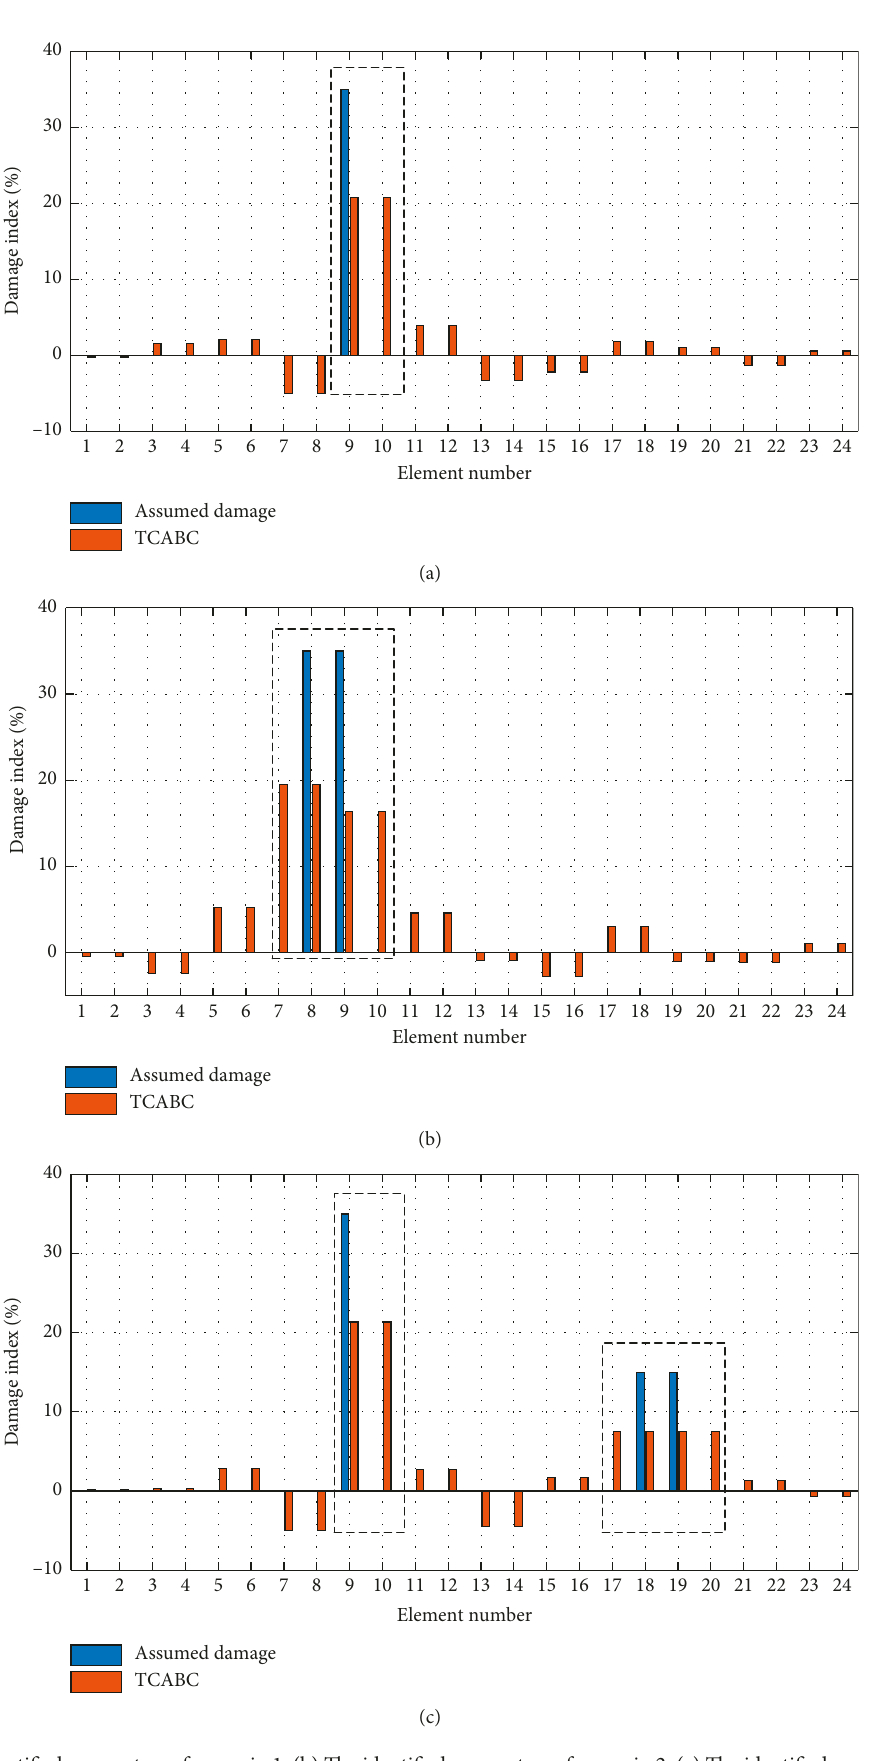
Figure 12: (a) The identified parameters of scenario 1. (b) The identified parameters of scenario 2. (c) The identified parameters of scenario